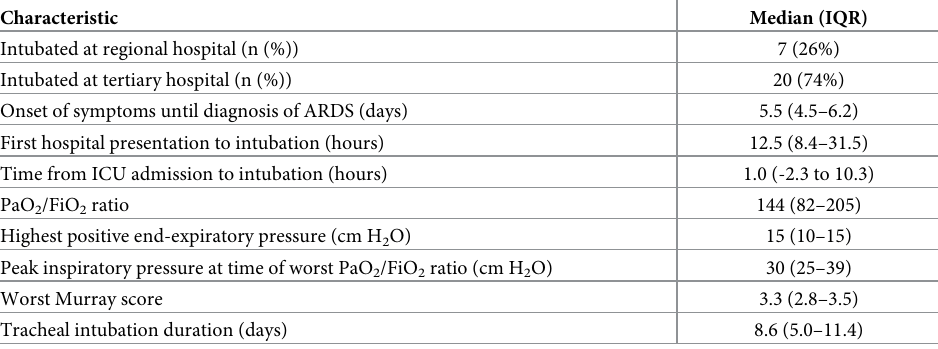
Table 6. Characteristics of patients with severe leptospirosis requiring ventilatory support and intubation in Far North Queensland, Australia between 1997 and 2018.